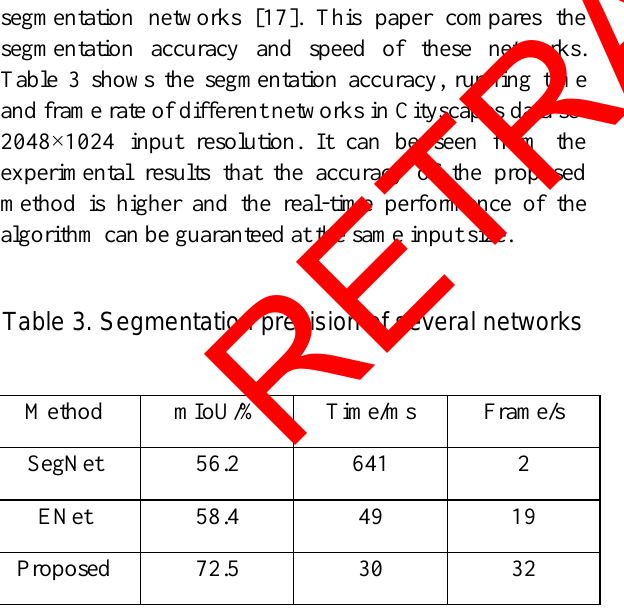
Table 3. Segmentation precision of several networks